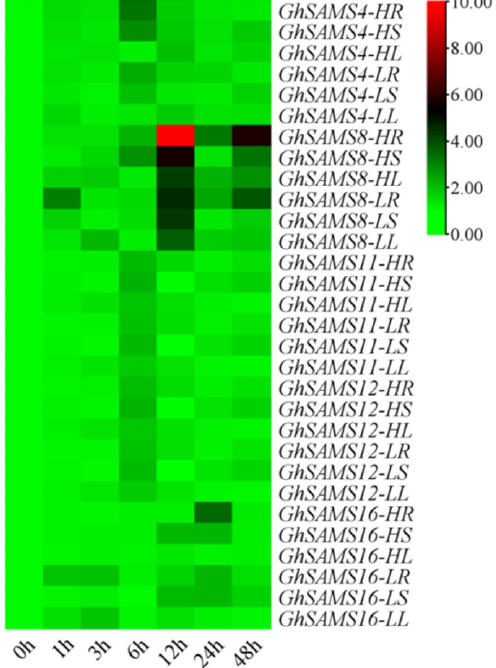
Figure 7. The expression of GhSAMS under drought stresses (log 2 (FPKM)).